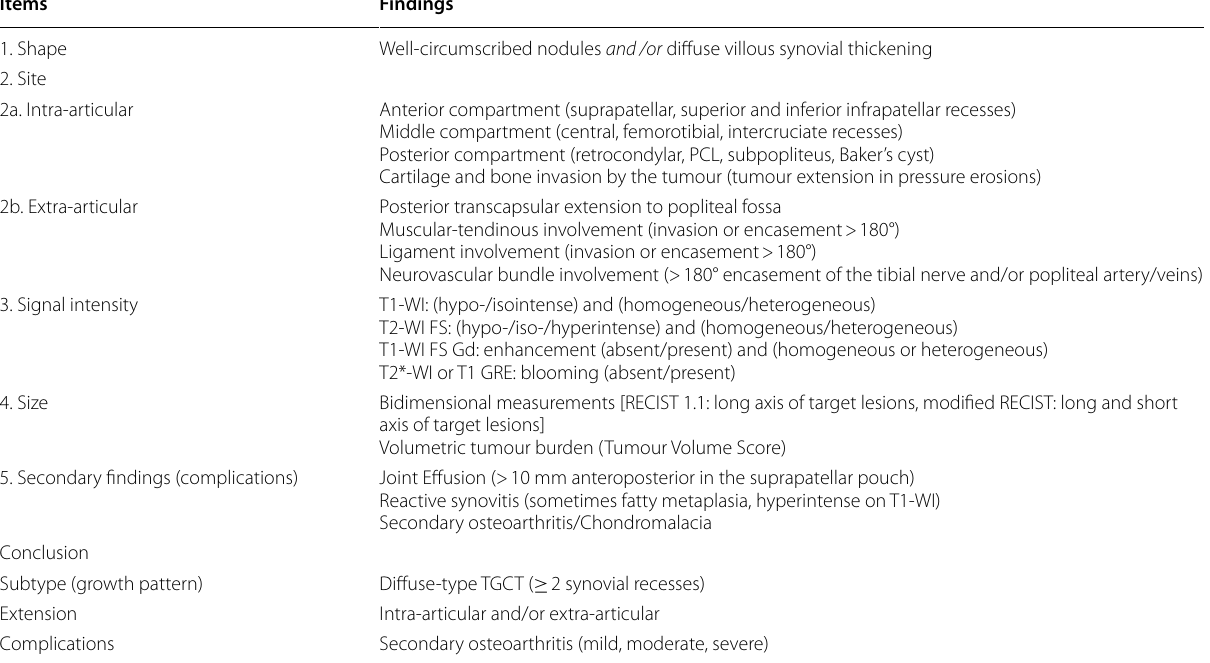
Table 1 D-TGCT Knee MRI structured report template